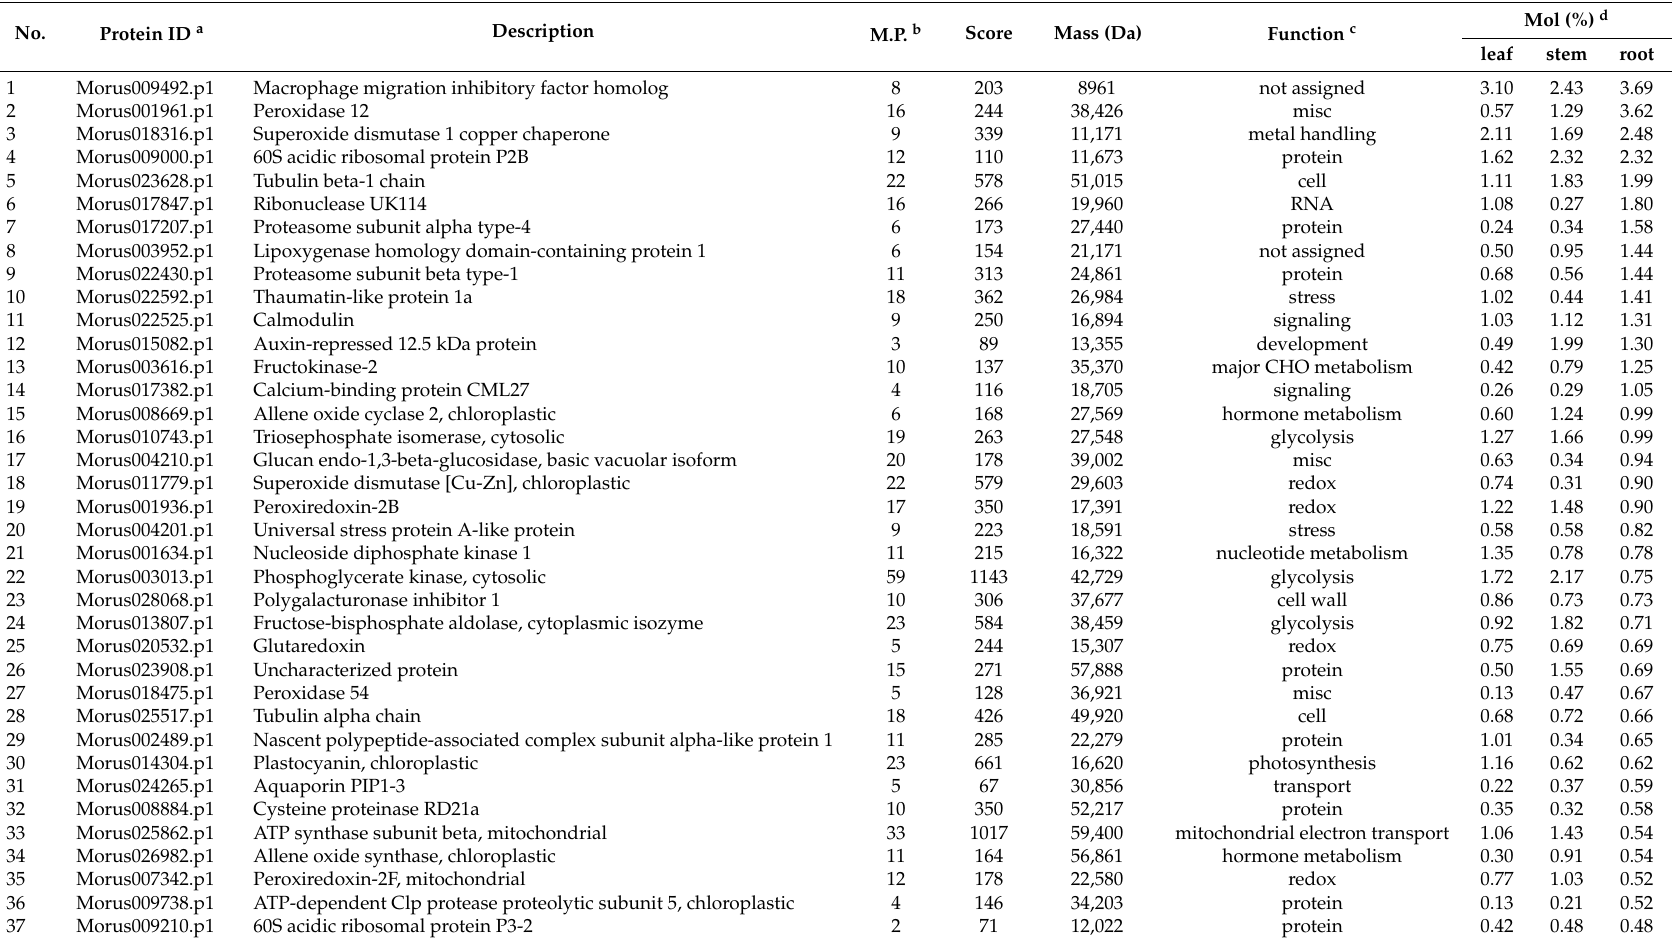
Table 2. Common proteins identified in the leaf, branch, and root of Morus by gel-free/label-free proteomic